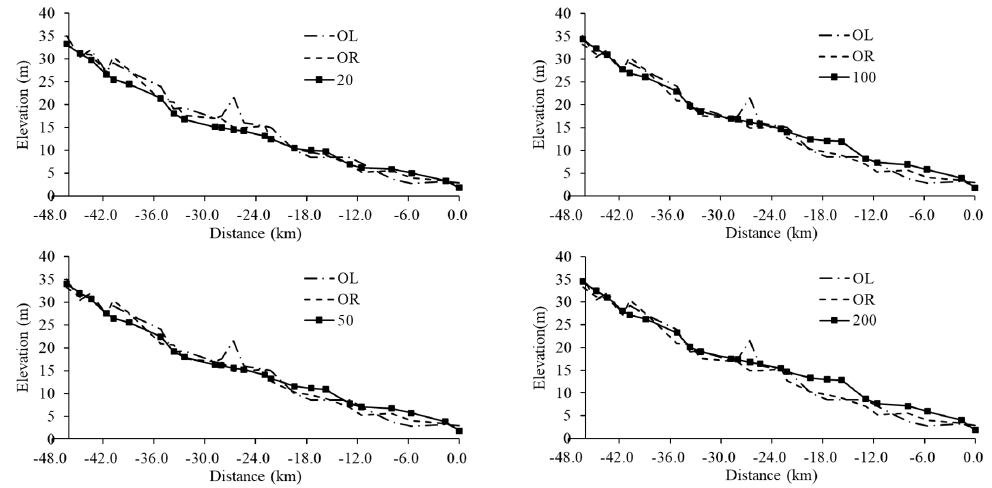
Figure 5. Simulation results of river flood of different frequencies (OL means elevation of original left bank of the river, OR means elevation of original right bank of the river, Numbers mean water level of simulation of results of different frequencies).